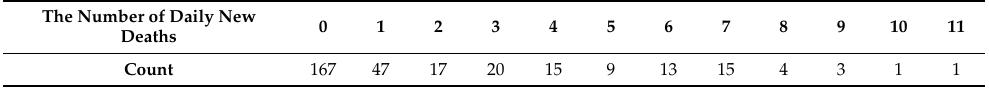
Table 3. The number of COVID-19 daily new deaths in Luxembourg in